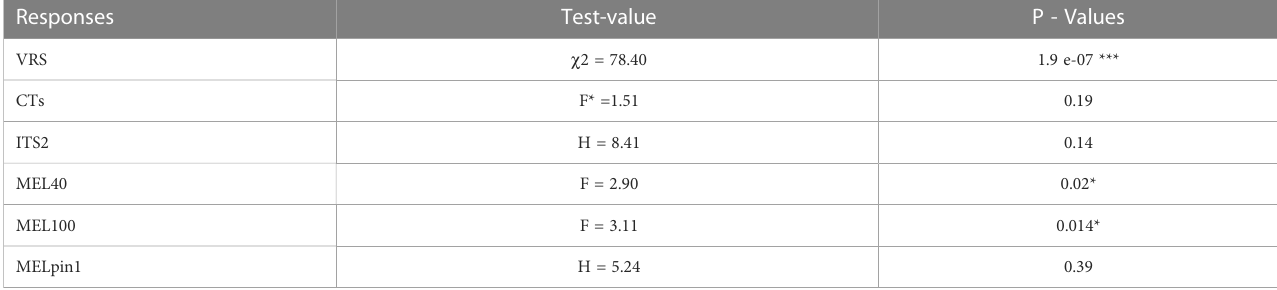
TABLE 3 Test values measuring the effects of aspen genotype on foliar rust related responses including visual rust scores determined in the fi eld (VRS, Figure 1 ), foliar concentrations of Condensed Tannins (CTs, mg/g DW), and molecular markers representing the overall fungal load (ITS2) as well as the abundance of fungi belonging to the Melampsora genus (using the MEL40 and 100 primers) and the native rust M. pinitorqua (using the MELpin1